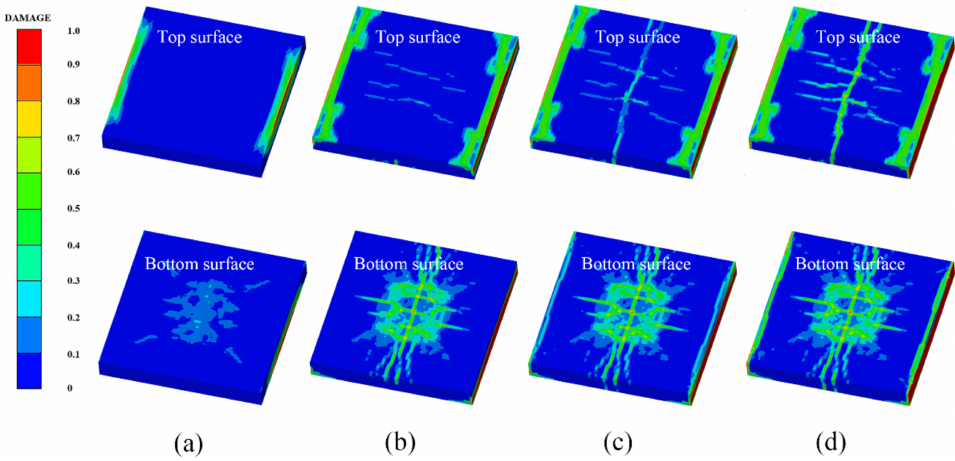
Figure 18. Damage process of the CEL model: ( a ) 0.3 ms, ( b ) 0.9 ms, ( c ) 1.2 ms, ( d ) 2.0 ms.